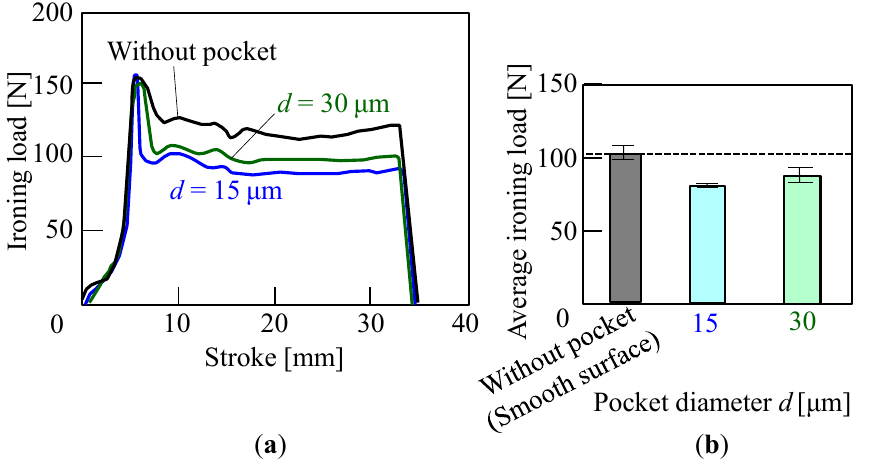
Figure 12. Ironing load of aluminum alloy sheets with grid array patterns, h = 2 µ m, L = 50 µ m and r = 10%: ( a ) load-travel diagram and ( b ) average ironing load.